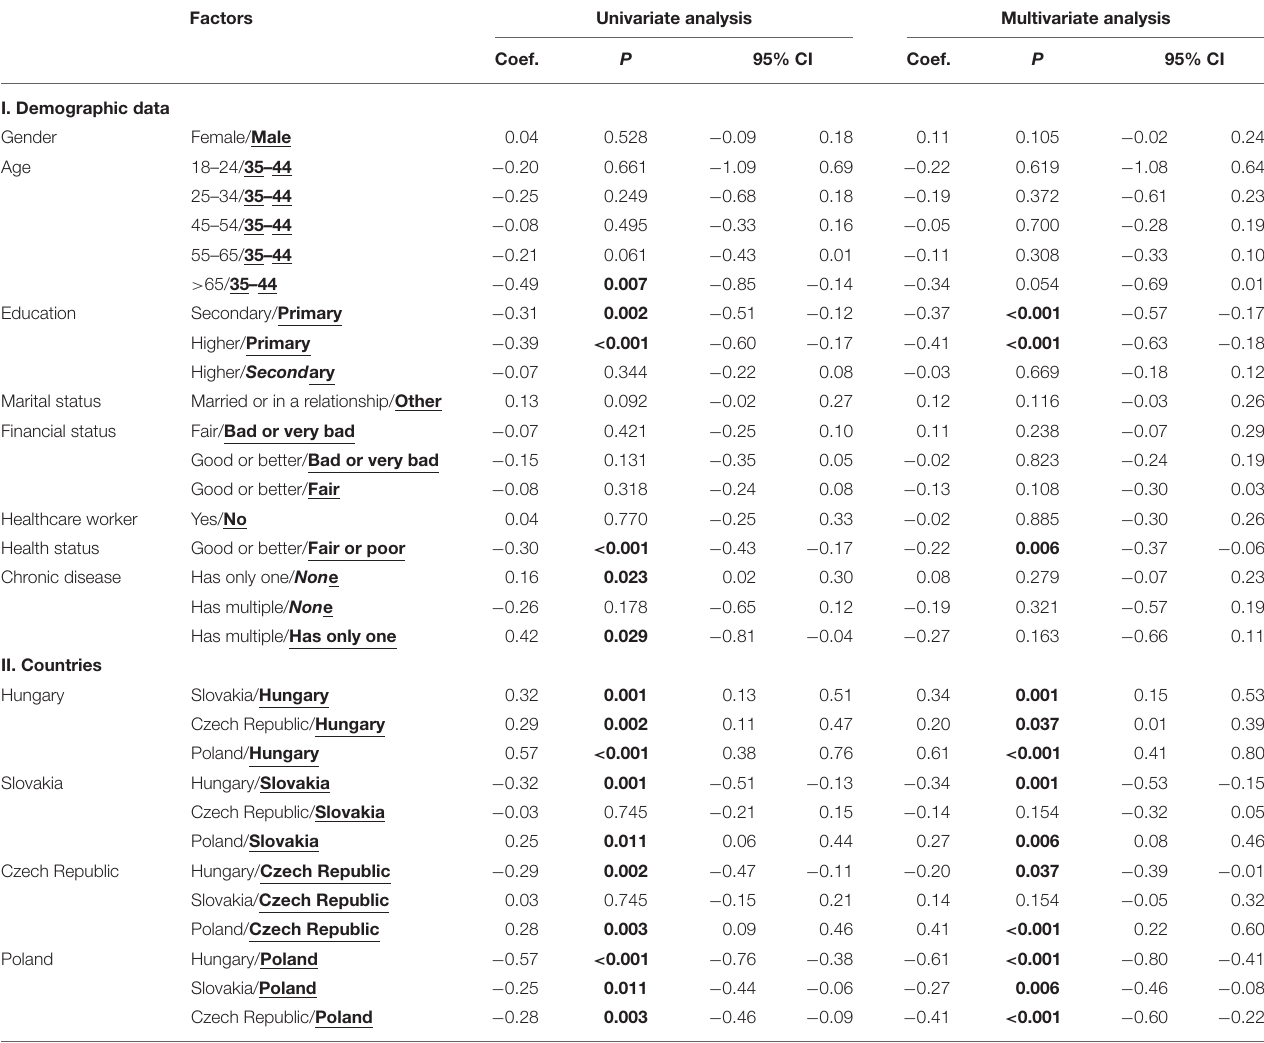
TABLE 3 | Multivariate analysis of necessity within the Visegrad Group countries. Factors Univariate analysis Multivariate analysis Coef. 95% CI